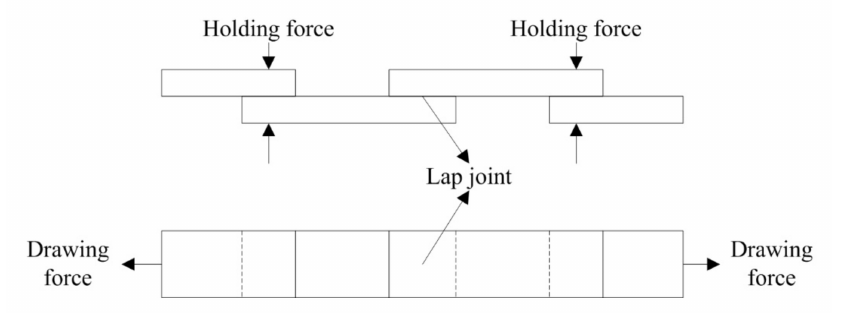
Figure 2. Schematic diagram of shear test specimen.